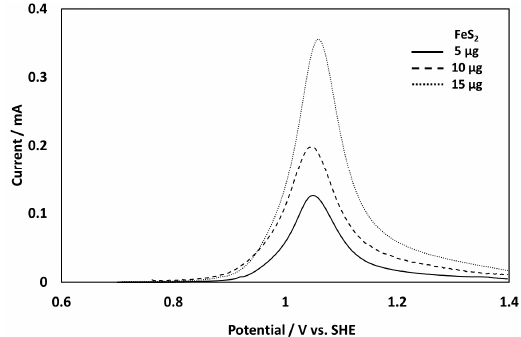
Figure 2. Effect of the attached amount of pyrite on the voltammogram. Potential polarization with 5–15 µg of pyrite that is attached to the platinum plate surface.